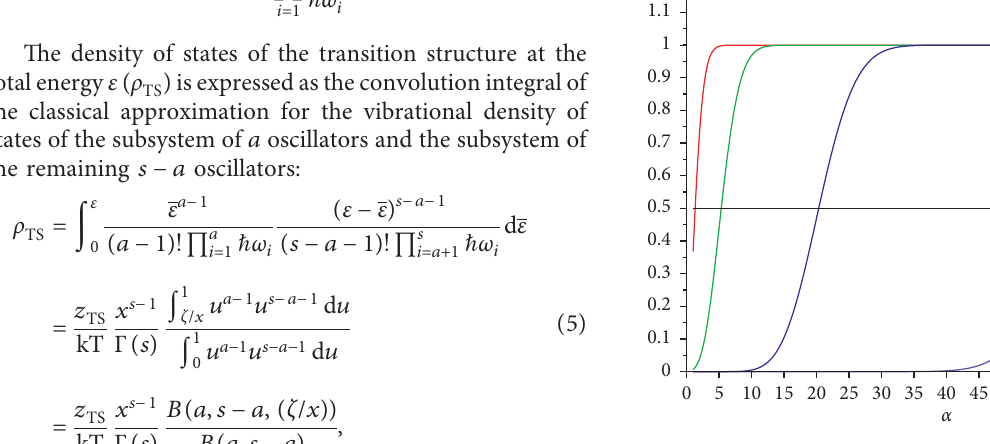
Figure 1: Plots of Q ( a, ζ ) versus a at various fixed values of ζ